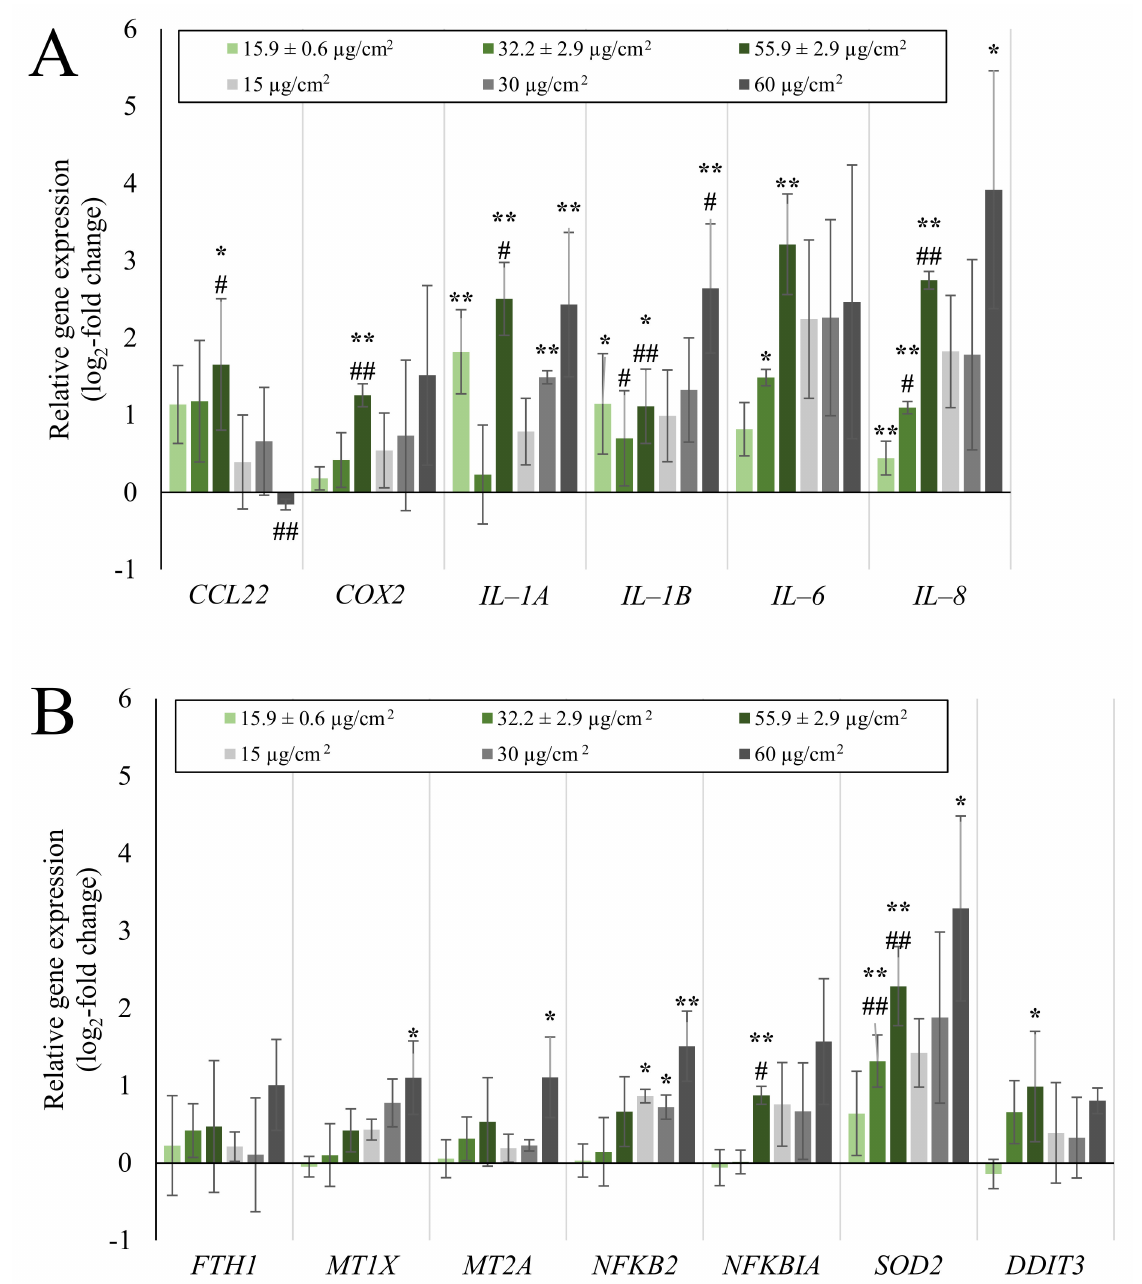
Figure 5. Impact of Min-U-Sil5 exposure on the expression of inflammatory genes ( A ) and genes of various gene clusters ( B ) significantly altered in their expression in pulmonary co-cultures after ALI (green bars) or submerged exposure (grey bars). Co-cultures comprised of A549 and dTHP-1 cells were exposed to three different doses of Min-U-Sil5 and incubated for 24 h. Results are depicted as the log 2 -fold change of the relative gene expression. The means ± SD of three independent experiments performed in duplicates are displayed. Statistical analysis was performed to assess differences between the exposed cells and the negative control with one-way ANOVA followed by Dunnett’s post hoc test: * ( p ≤ 0.05), ** ( p ≤ 0.01), or to compare differences between the A549 mono- and A549/dTHP-1 co-culture with student’s t -test: # ( p ≤ 0.05), ## ( p ≤